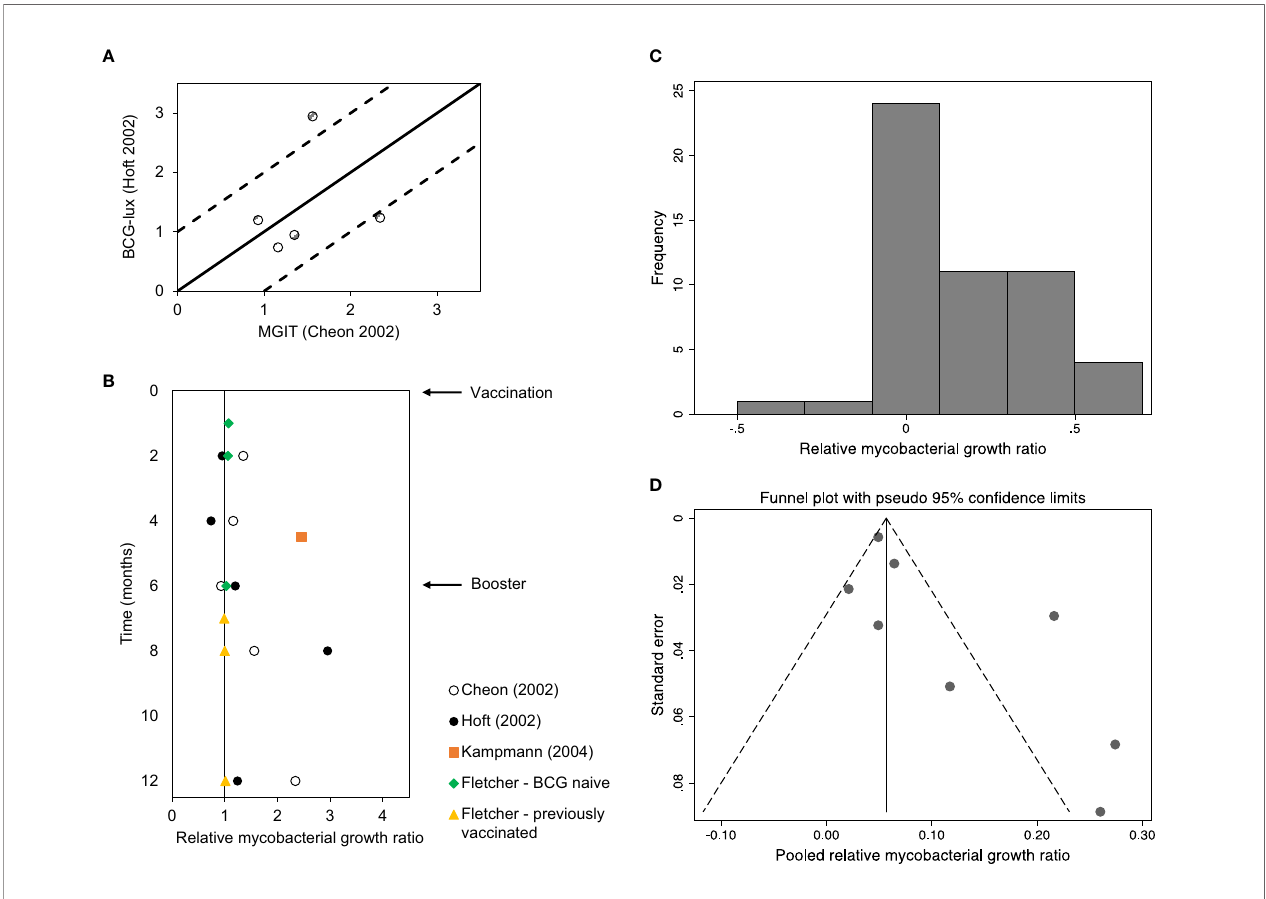
FIGURE 3 | (A) Relative mycobacterial growth (ratios) of BCG vaccination studies using the same population but different assays. The solid line represents no difference between assay results. The dotted lines represent a 2-fold difference between assay results. (B) Relative mycobacterial growth (ratios) of BCG vaccination studies per month post-vaccination. (C) Histogram of log 10 of relative mycobacterial growth ratios. Note this refers to the ratios as presented in Figures 2A – E . (D) Pseudo-funnel plot (see Methods